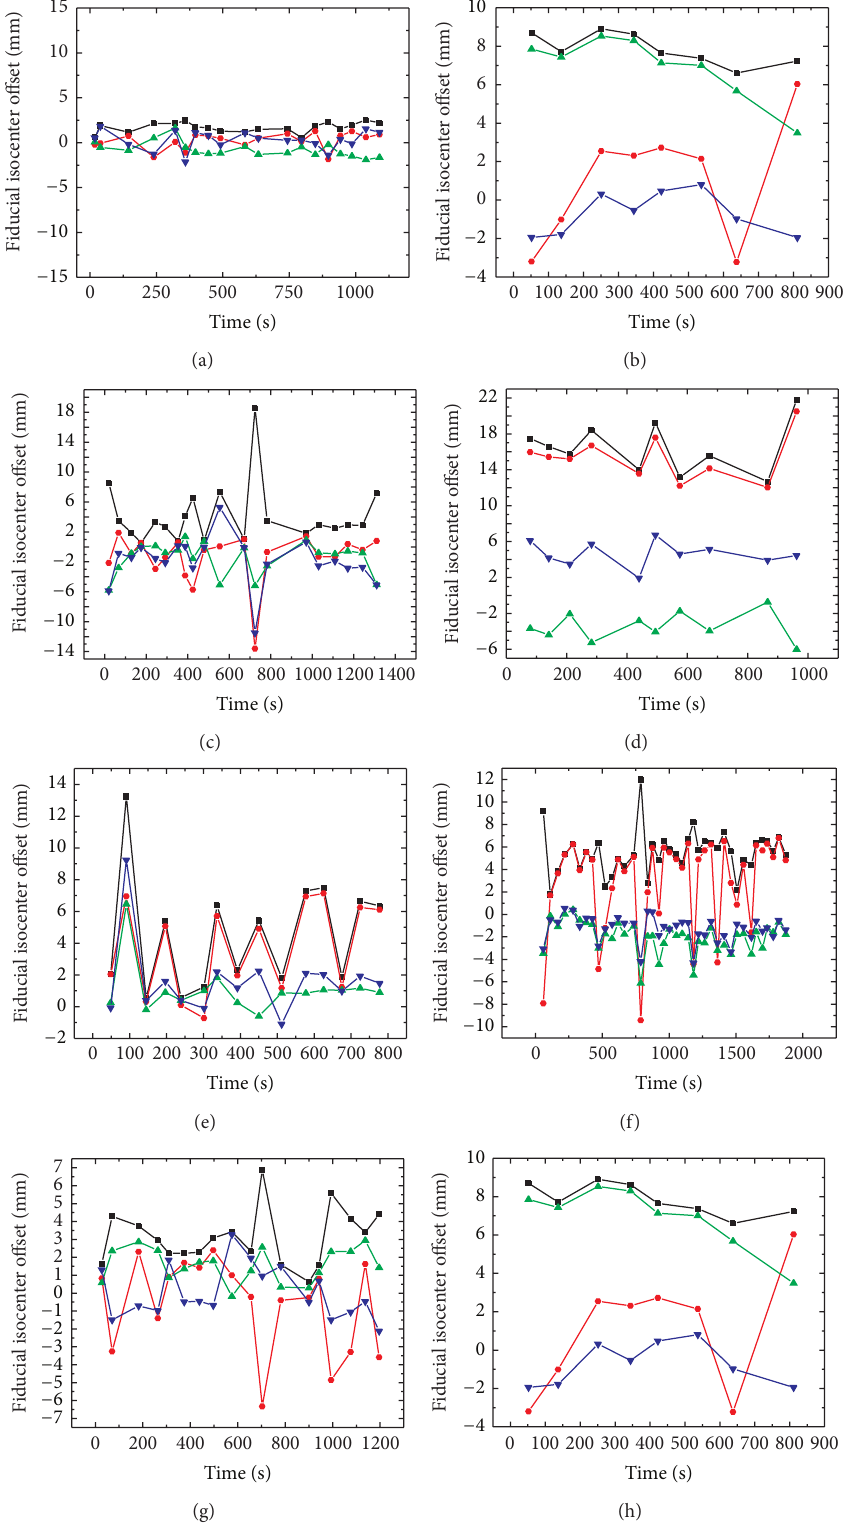
Figure 2: Patterns of pancreas movement: (a) stable positioning at baseline; (b) dropping down; (c) transient excursion; (d) persistent excursion; (e) high-frequency excursions; (f) intermittent vibration; (g) radon movement; (h) and LR moving (red: SI direction; green: LR direction; blue: AP direction; and black: